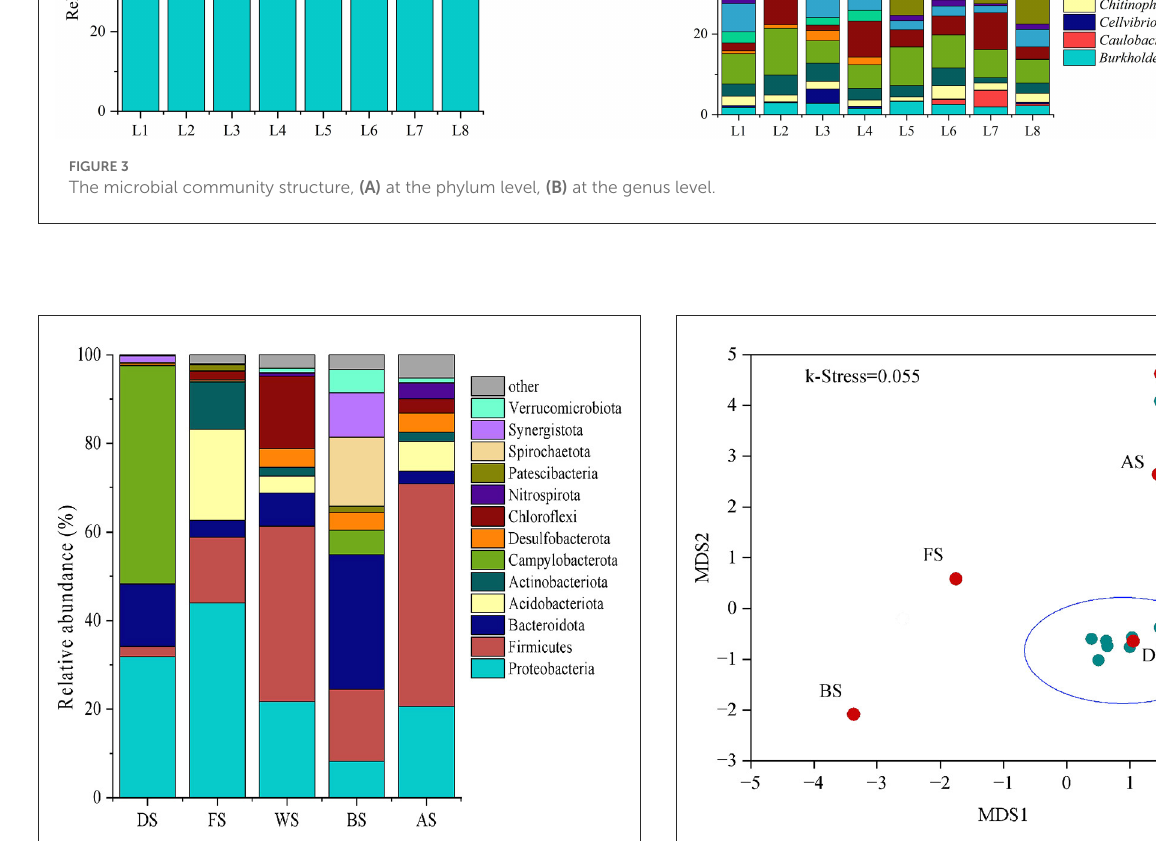
FIGURE4 The microbial community structure at the phylum level for potential pollution sources (FS, industry; DS, urban land; AS, culture ponds; BS, livestock; WS, farmland).